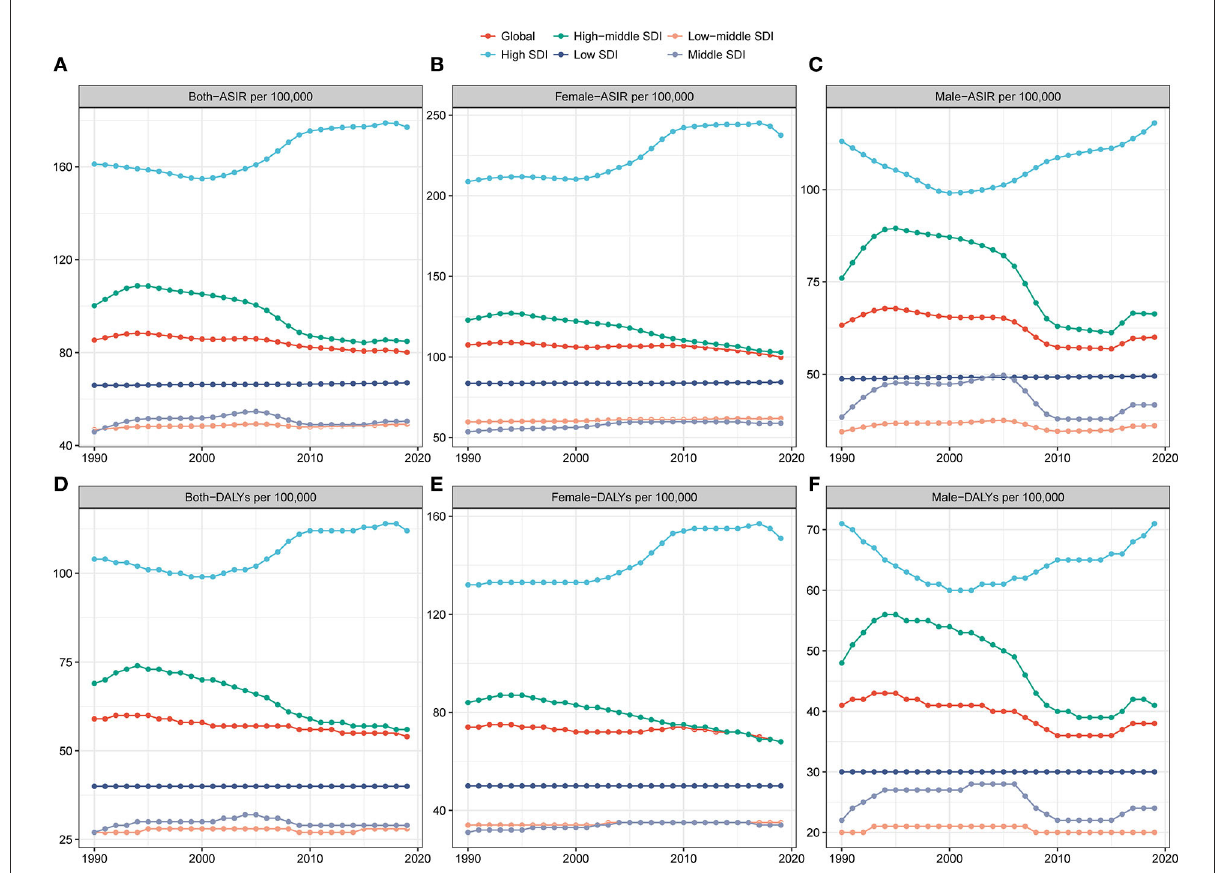
FIGURE3 Change trends of age-standardized incidence rate (ASIR) and age-standardized disability-adjusted life year (DALY) rate among different genders and different socio-demographic index (SDI) quintiles. (A–C) ASIR; (D–F) age-standardized DALY rate.